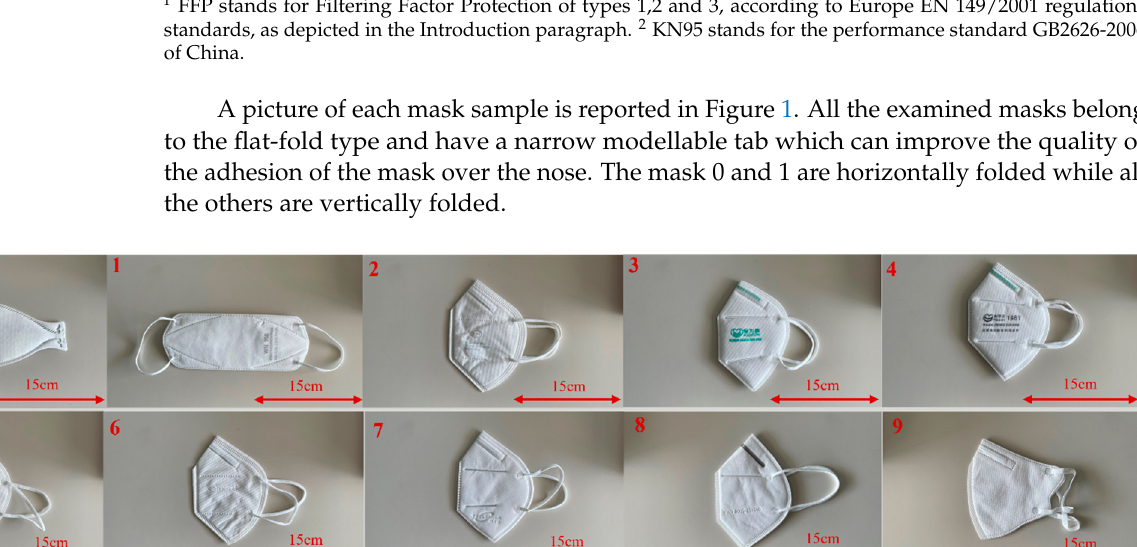
Table 1. Name, sequential sample number, and certification type of each tested device.